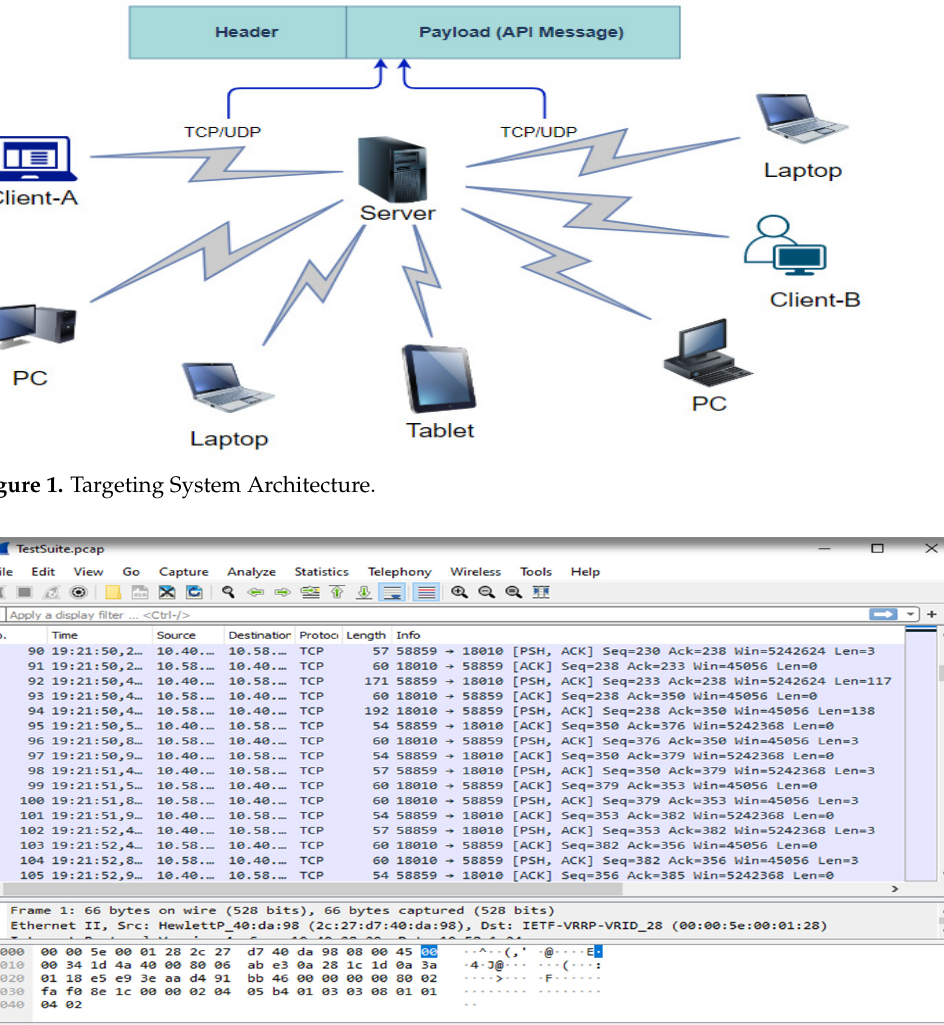
Figure 2. Screenshot of Wireshark displaying TCP data packets of a TestSuite.pcap file.